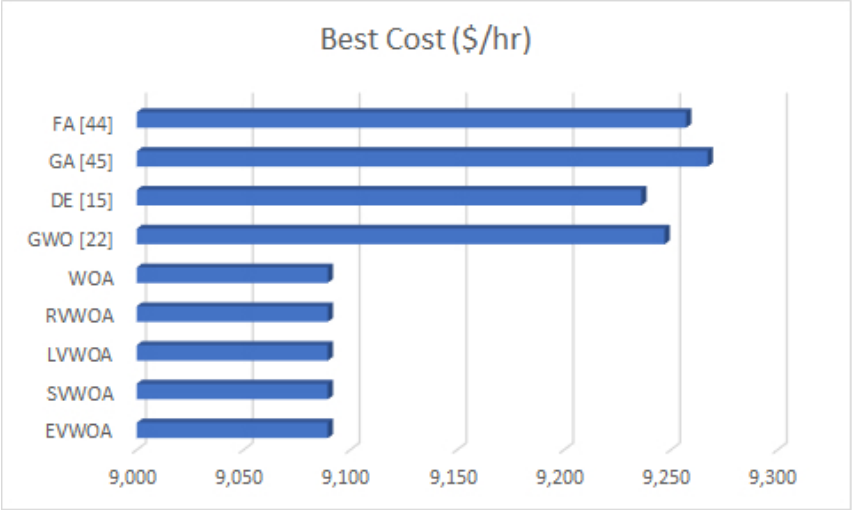
Figure 9. Best Cost Comparison for Case Study 1.